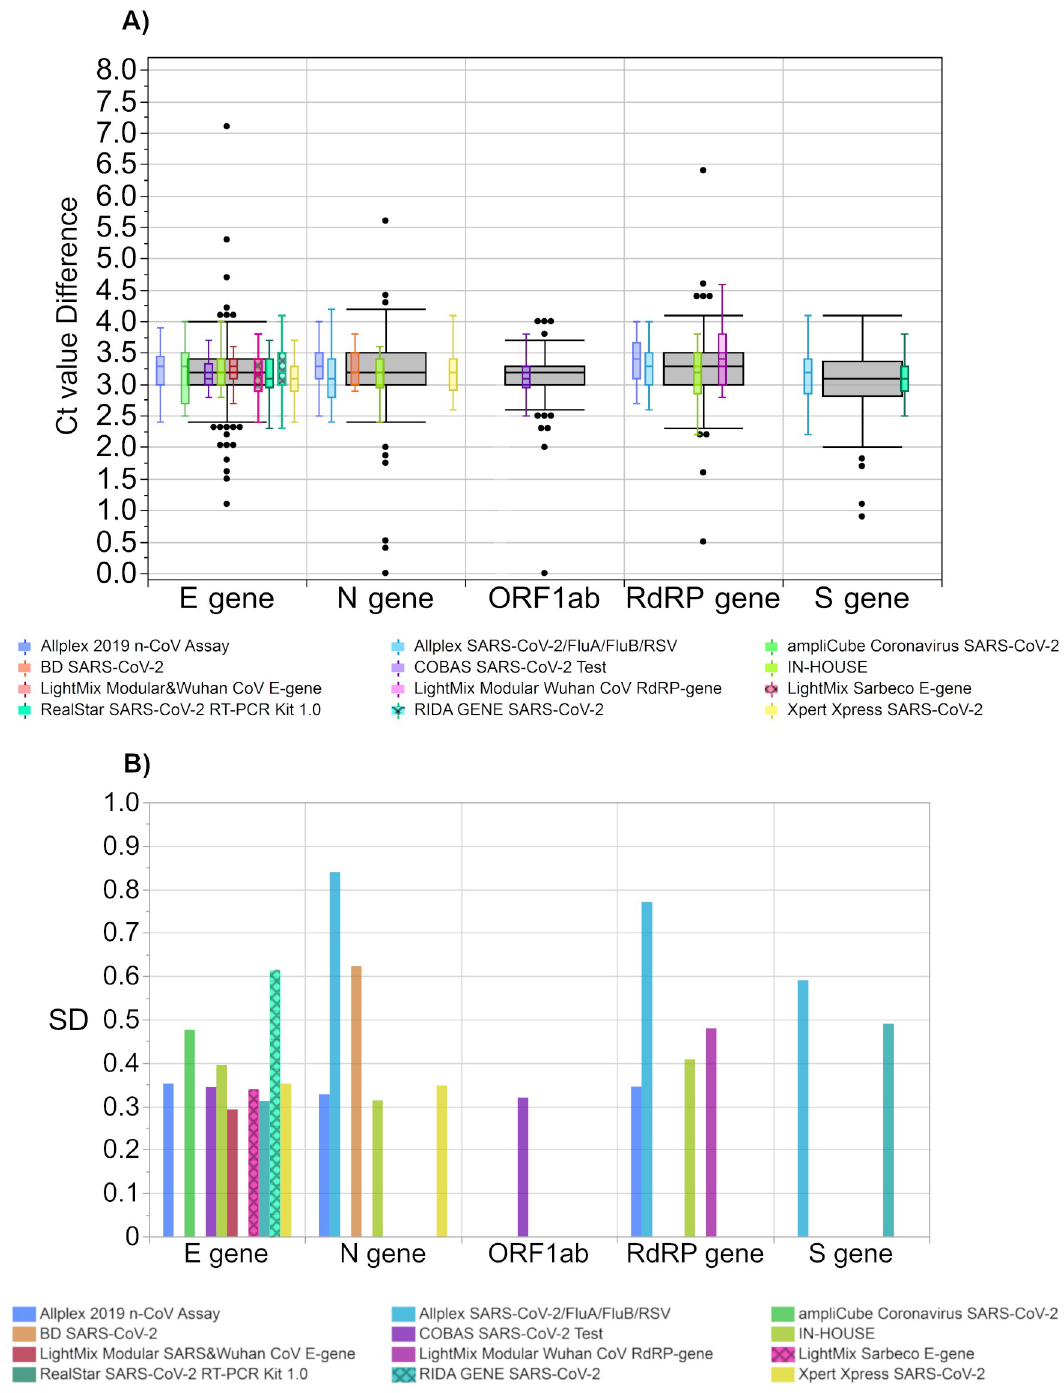
Fig 10. (A) Ct value difference between both samples per test system and (B) their respective standard deviations (SD). The grey boxes display all results for the respective sample, and the distributions of specific manufacturer-based collectives are illustrated as smaller, colored box plots in overlay with the total results. Outlier were excluded from colored boxes. For all boxes, the whiskers stretch from the 1st quartile—1.5 � (interquartile range) to the 3rd quartile + 1.5 � (interquartile range).